Question: Does the plotted quantity increase or decrease?
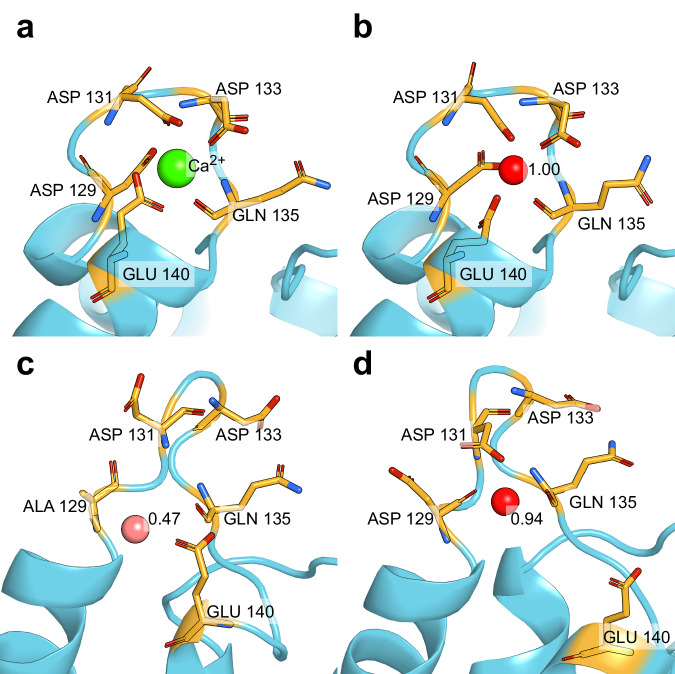
Answer: increasing